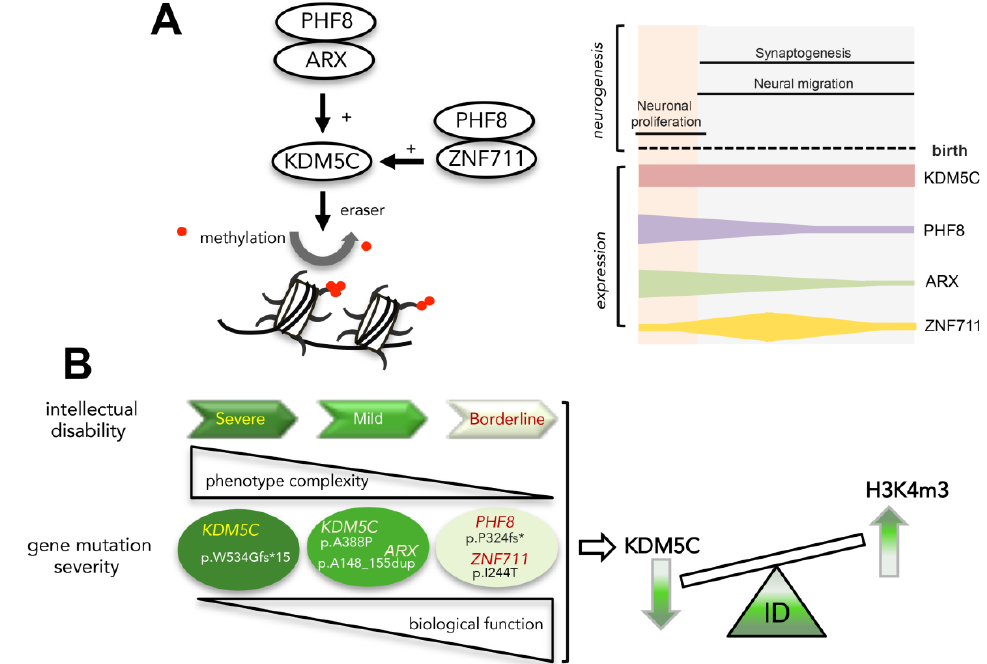
Figure 8. KDM5C is an epigenetic marker of ID severity. Regulatory governance of KDM5C transcription ( A , left panel ); and expression profiles of KDM5C and its regulatory genes during human neurogenesis ( A , right panel ); functional correlation between mutation severity and ID ( B